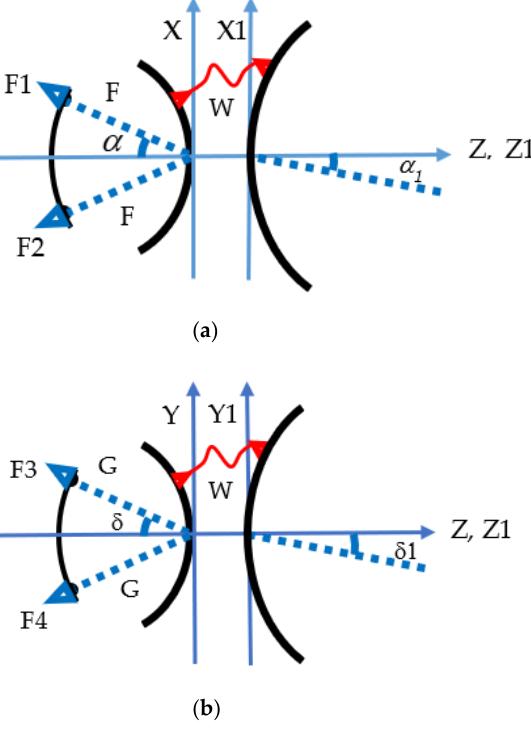
Figure 3. ( a ) Variables in the X-Z plane; ( b ) variables in the Y-Z plane.